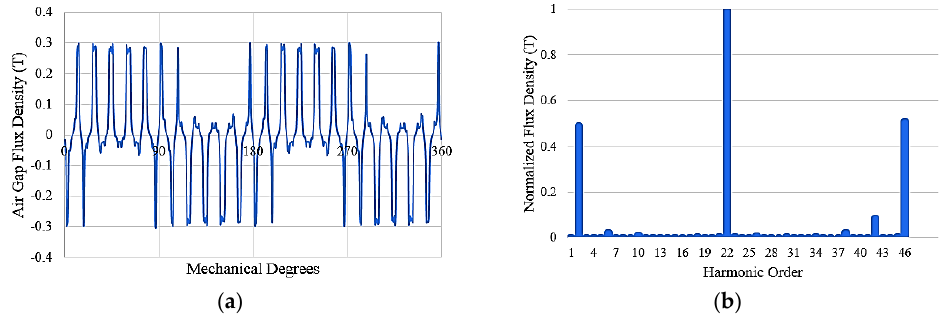
Figure 4. ( a ) Air gap flux density; ( b ) Harmonic order of no-load flux density.